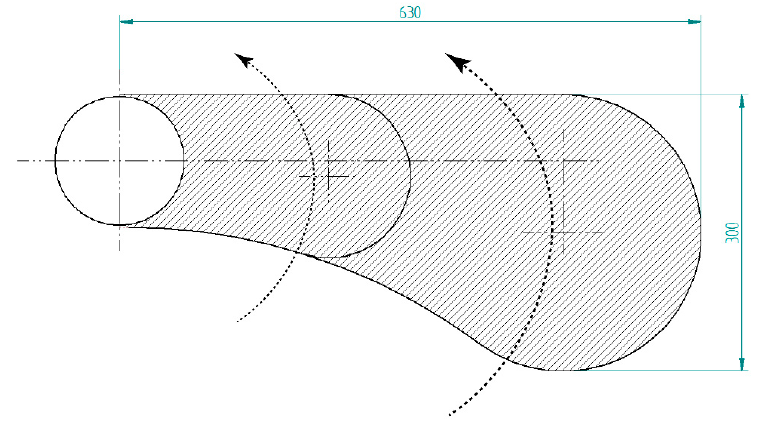
Figure 7. Key dimensions of TA2, arrow showing expected rotation direction.